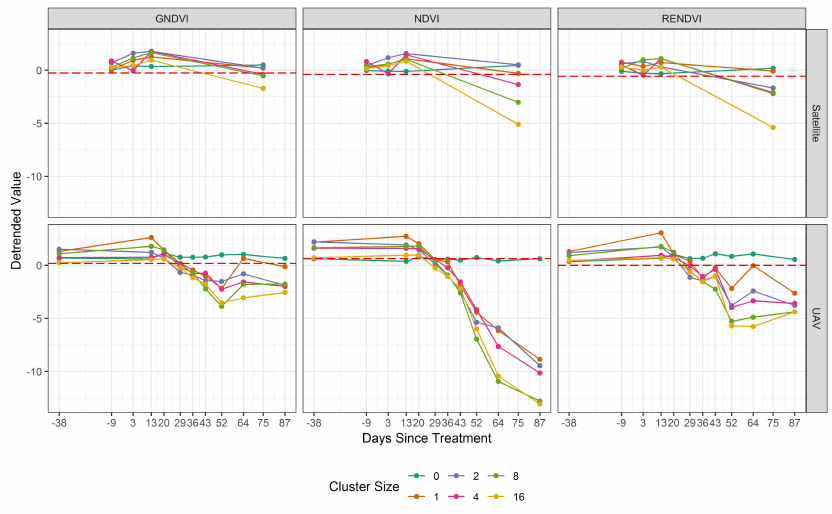
Figure 3. Each datum represents the 75th percentile of the spectral indices for an experimental cluster size for both sensors across the duration of the study. The control plots where no trees were treated are represented by the cluster size = 0. The red dashed line shows the 25th percentile of the pre-treatment values and defines the lower bound of the ‘no-change’ region for a spectral index. The UAV results plotted here have been previously displayed in [12].